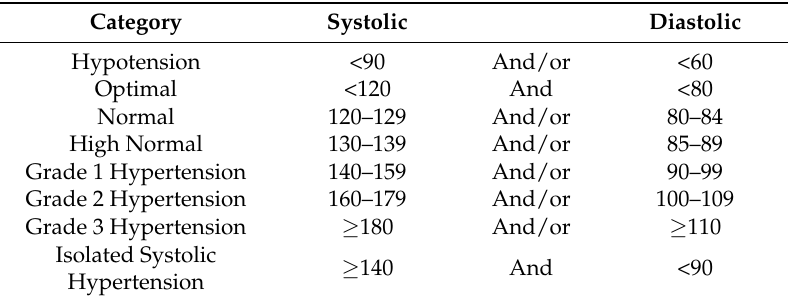
Table 1. Definitions and classification of blood pressure